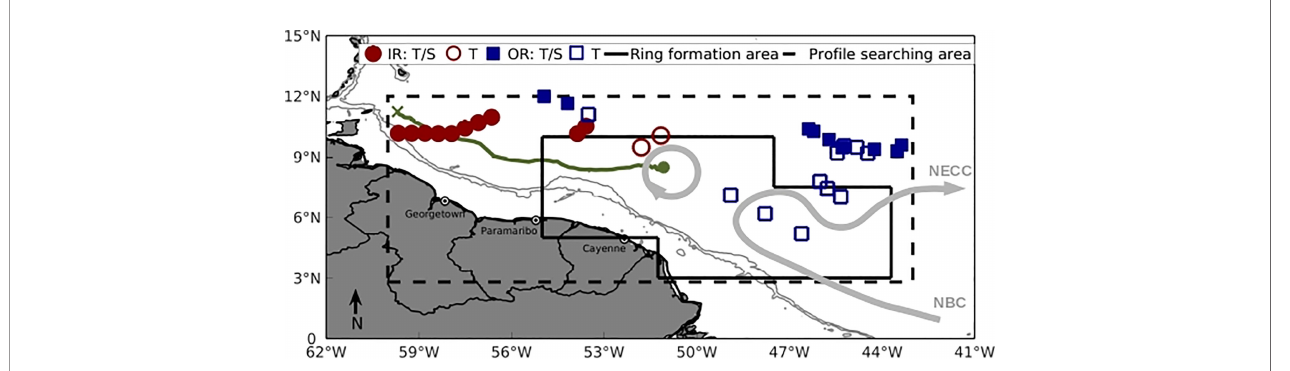
FIGURE 1 | Searching area (dashed lines) for T and S pro fi les and for ring trajectories originated at the NBC retro fl ection (ring formation area, de fi ned by solid lines). See text for details. The green line indicates the trajectory of one NBC ring, originated near 51°W and 8°N, illustrating the selection of T and S pro fi les as IR (circles) or OR (squares). Filled markers indicate that T and S pro fi les were available (from CTD casts or ARGO fl oats), while empty markers indicate that only T pro fi les were available (from MBTs or XBTs). The ring, the NBC and NECC are illustrated schematically by the thick gray lines, for reference. The thin gray lines are the 200 and 1000 m